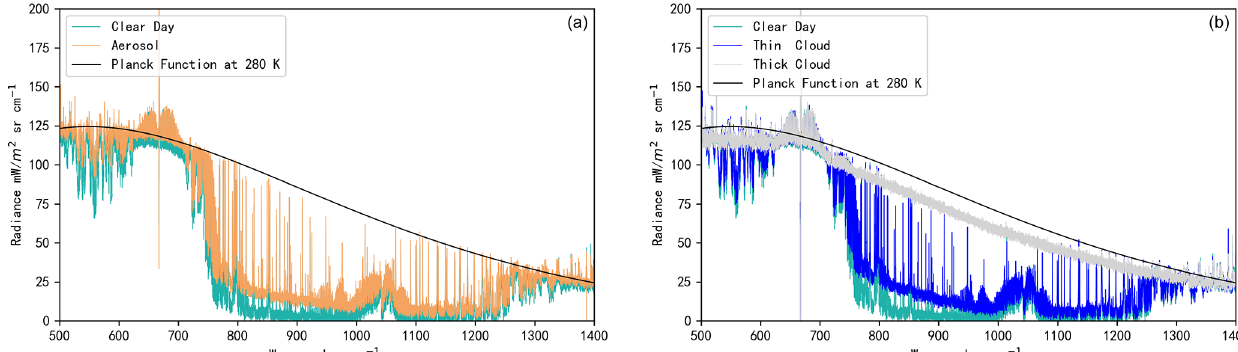
Figure 1. Four different emission spectra measured by the NYAEM-FTS under (a, b) clear-sky (green), (a) aerosol event (yellow), (b) thin-cloud (blue), and (b) thick-cloud (gray) conditions, respectively. The radiance calculated using Planck function at 280K (black line) is presented in this figure. Note that the emission at around 650cm − 1 originates under ambient CO 2 conditions from the laboratory air. Table 1. Aerosol classification by lidar measurements, as per the classification system defined by Ritter et al. (2016). Classes δ aer CR Description 532 “clear” β < 0 . 4 δ < 2 . 05% Clear day “clear depol.” β < 0 . 4 δ ≥ 2 . 05% Clear day with polarized signal “spherical aerosol” 0 . 4 ≤ β < 1 δ < 2 . 05% Spherical fine particles, possibly from long- distance transport (e.g., sulfate) “depol. aerosol” 0 . 4 ≤ β < 1 δ ≥ 2 . 05% Polarized fine particles with irregular shapes (e.g., dust) “activated aerosol” 1 ≤ β ≤ 3 δ < 2 . 05% CR < 1 . 7 Aerosol hygroscopic growth to a larger size (e.g., sea salt and sulfates) “dense aerosol” 1 ≤ β ≤ 3 CR ≥ 1 . 7 Medium-sized aerosol (e.g., sea salt and dust) Cloud β > 3